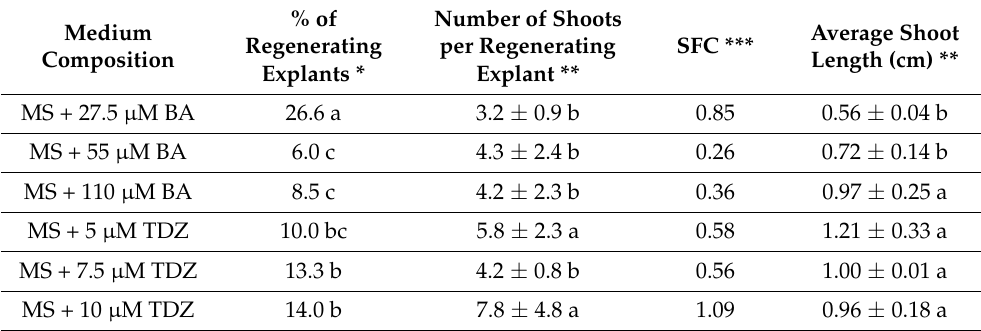
Table 3. De novo regeneration of Arachis hypogaea L. cv. Virginia shoots on de-embryonated cotyle- dons, when cultured on semi-solid MS